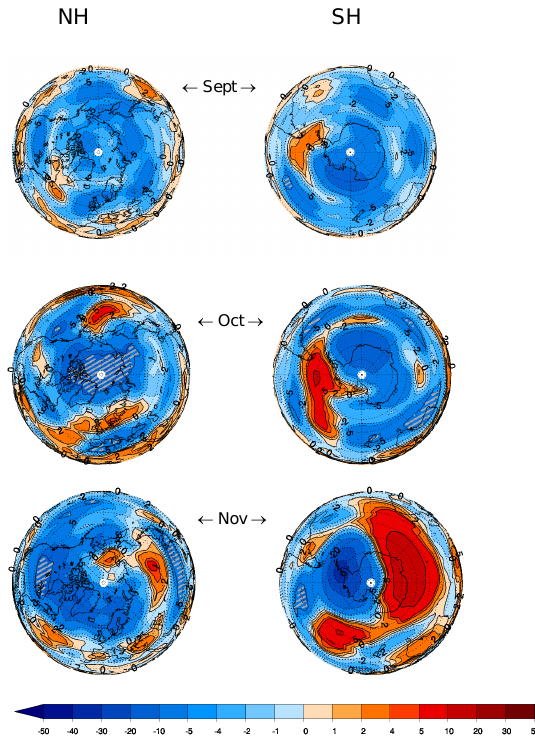
Fig. 7: Left column: Polar stereographic projection of changes in total ozone (in DU) for the 470 Fig. 7. Left column: polar stereographic projection of changes in NH from September to November resulting from the Carrington-like event. Right column: 471 total ozone (inDU) for the NH from September to November re- Same for the SH. Hatched areas show 95 % statistical significance. 472 sulting from the Carrington-like event. Right column: same for the SH. Hatched areas show 95% statistical